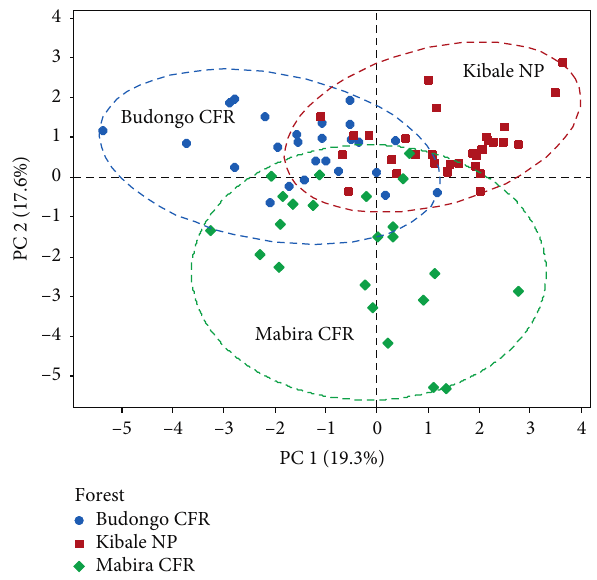
Figure 6: Principal component analysis of soil chemical param- eters for Budongo Central Forest Reserve, Mabira Central Forest Reserve, and Kibale National Park in